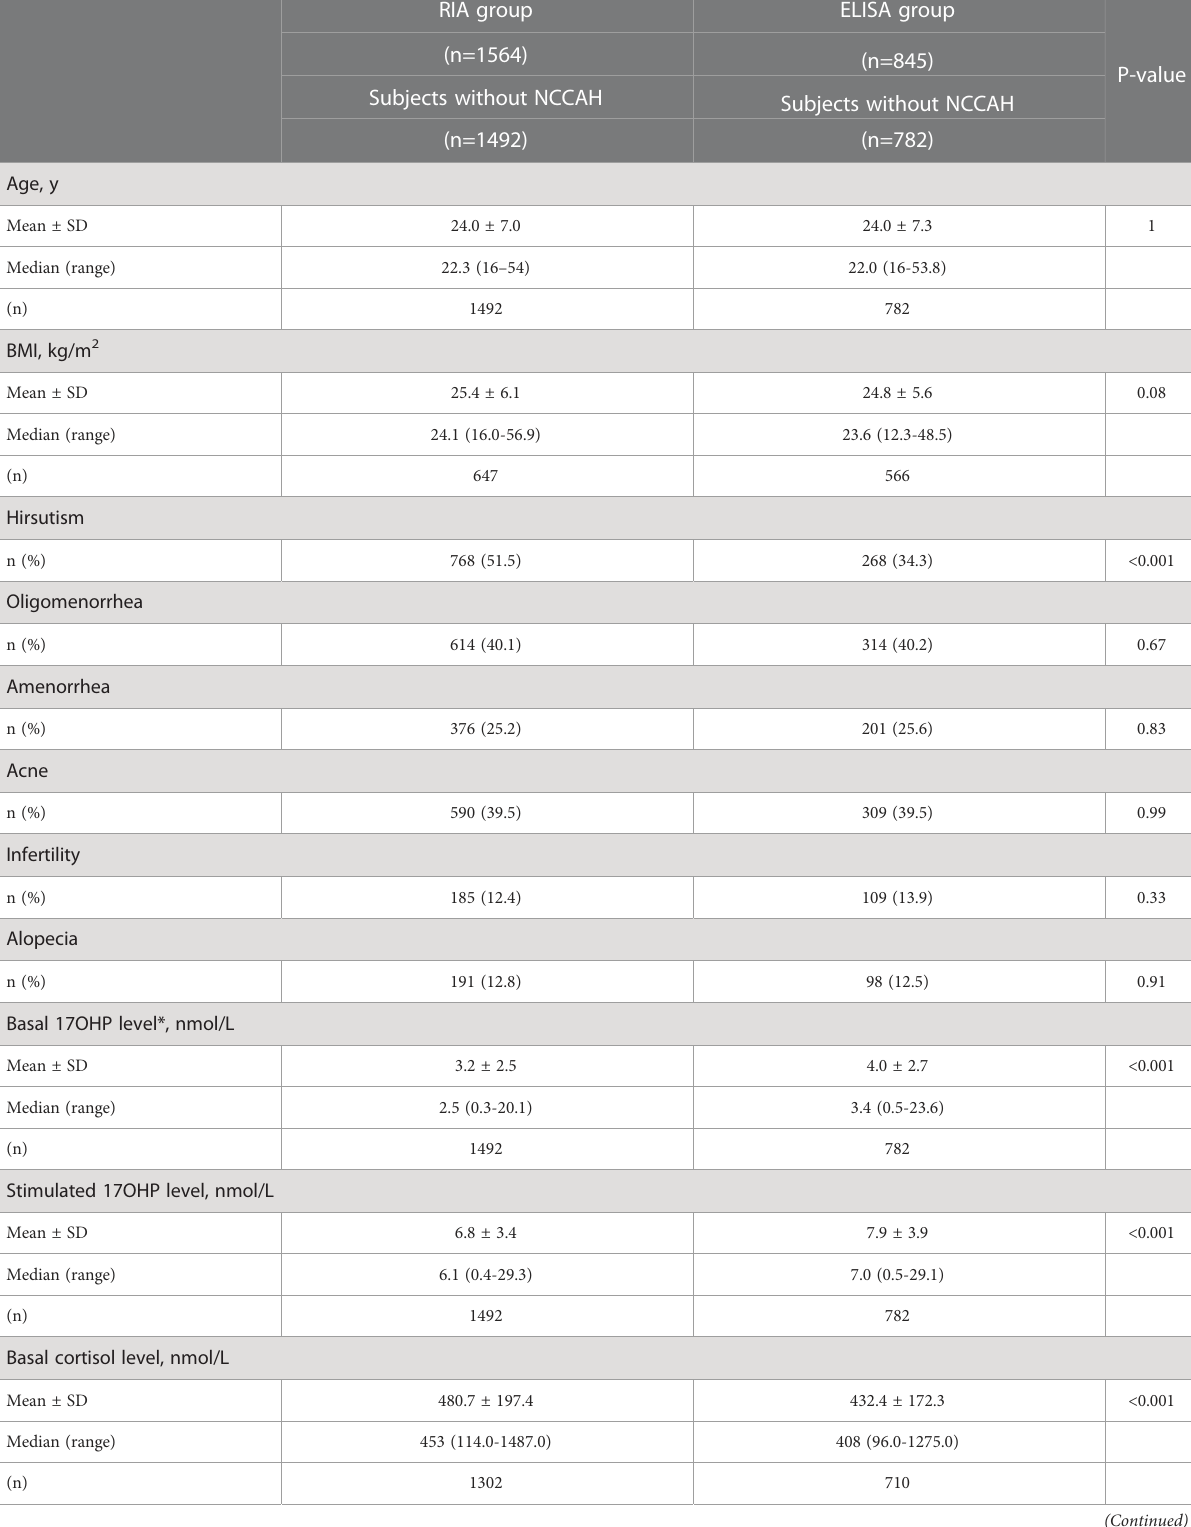
TABLE 2 Comparison of clinical and biochemical characteristics among women without NCCAH from the RIA and the ELISA